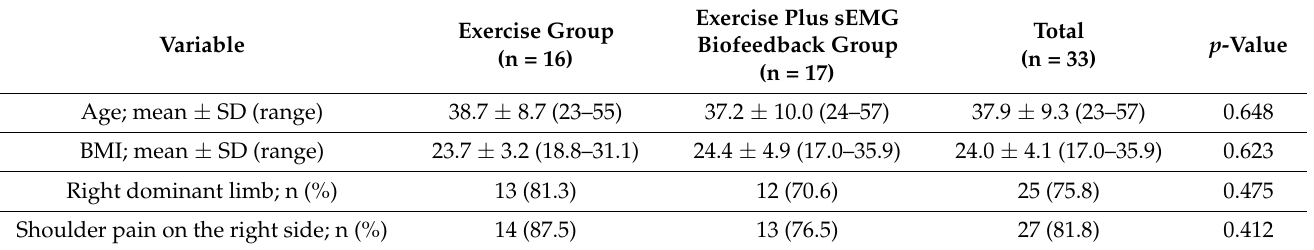
Table 1. Sample features, by